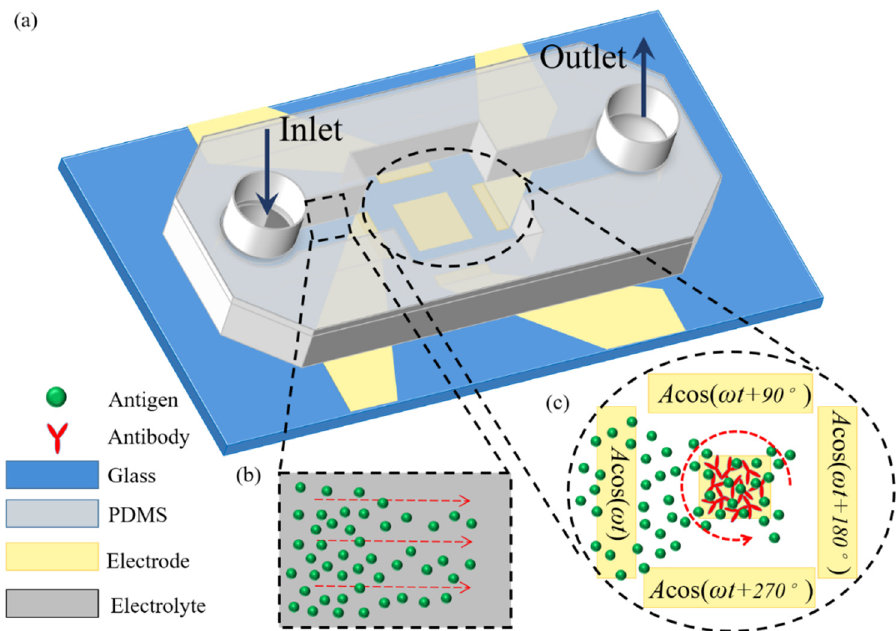
Figure 2. A 3D schematic illustration of ROT-ICEO-mediated antigen-antibody specific binding reaction on the conducting surface of the central FE encircled by a four-phase DE strip array, under the dynamic condition that an external pressure-driven laminar flow injects the target antigen samples from the inlet to the downstream outlet. Once they pass on top of the central FE, the localized ROT-ICEO vortex flow field disturbs the laminar streamlines and transports the antigens to the FE’s ideally polarizable surface, giving rise to more chance for the binding reaction between antigens and antibodies. ( a ) A 3D schematic of the dynamic immuno-sensor in the presence of continuous base flow. ( b ) A magnified view of the upstream flow passage before the suspended antigens pass by the reaction region. ( c ) An amplified view of the critical reaction region on top of the electrode array affected by electroconvection of ROT-ICEO.